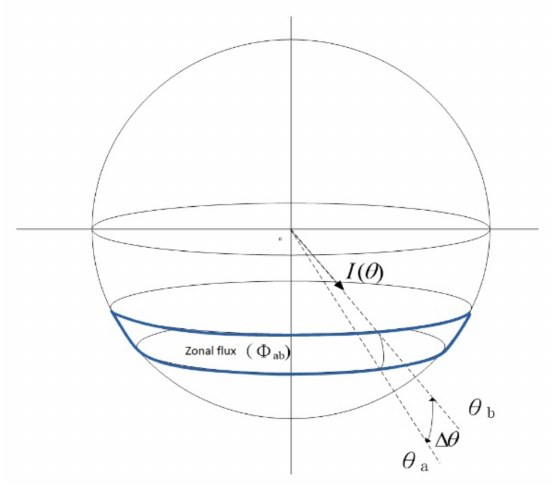
Figure 3. Schematic diagram of zonal flux calculation. Table 1. Zonal coefficients (vertical angle).